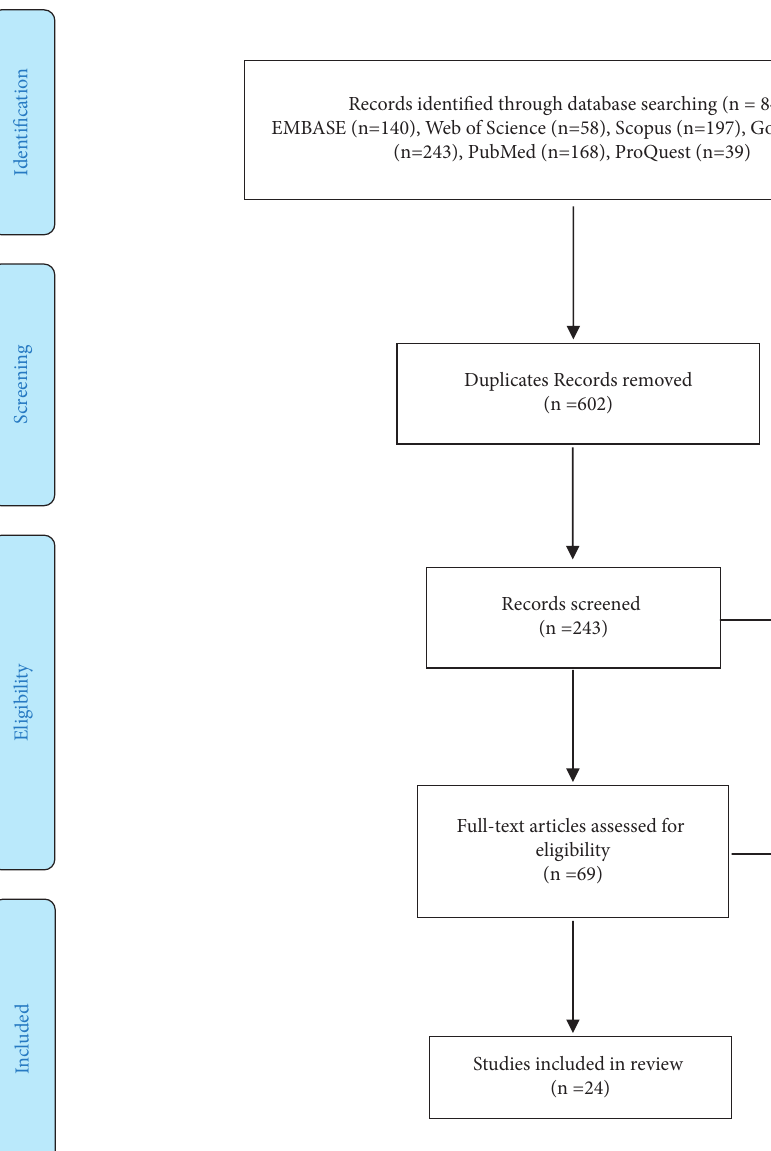
Figure 1: The PRISMA flowchart of the study selection